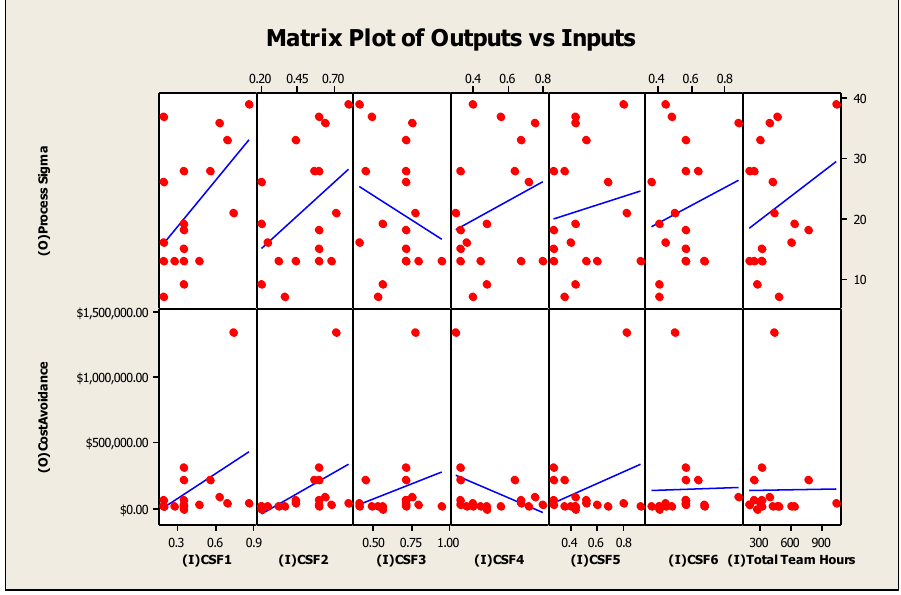
Figure 2. Correlation charts